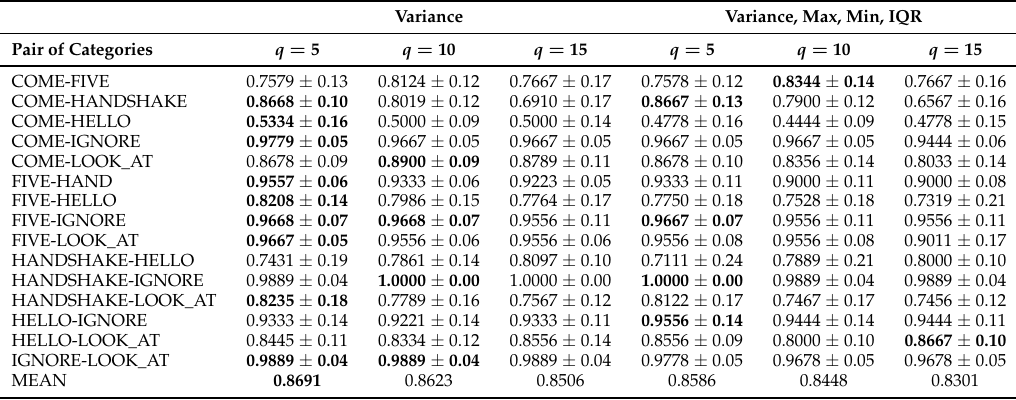
Table 2. Results obtained applying Common Spatial Patterns (CSP) with different q values and using LDA as